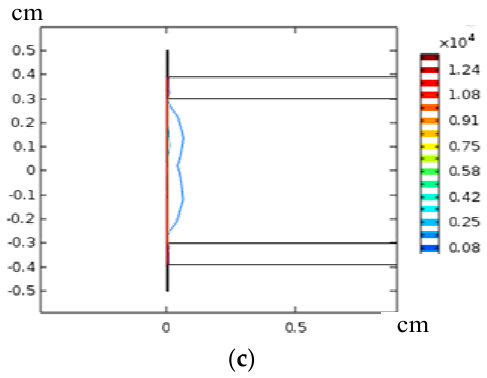
Figure 8. Isothermal curve in sandwich models (peak value of 12.56 kA, 50 μ s): ( a ) PVC; ( b ) PET; ( c ) balsa wood. Energies 2017 , 10 , 1594